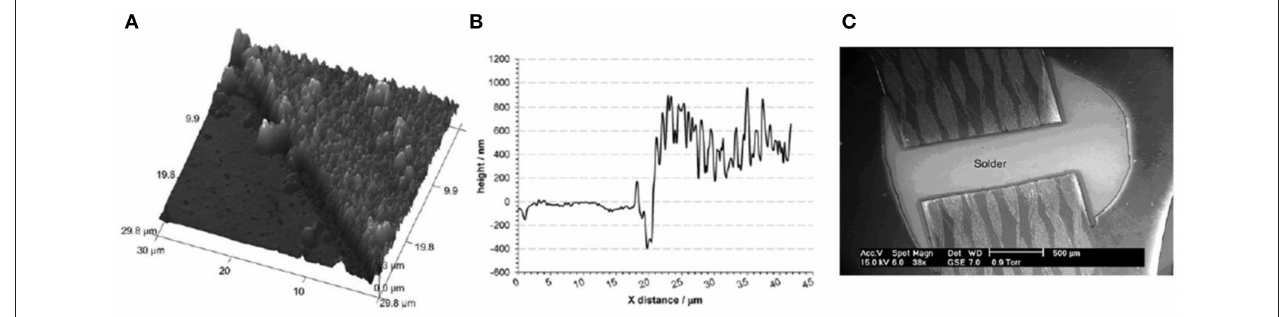
FIGURE 2 | (A) 3D AFM image of electroless deposited Ag on Cu (B) AFM height profile of the electroless deposited Ag on Cu shown in Figure 1A (C) Ag deposited on a printed circuit board. Reproduced from Abbott et al. (2007) and Abbott et al. (2008) with permission from The Royal Society of Chemistry and Elsevier.